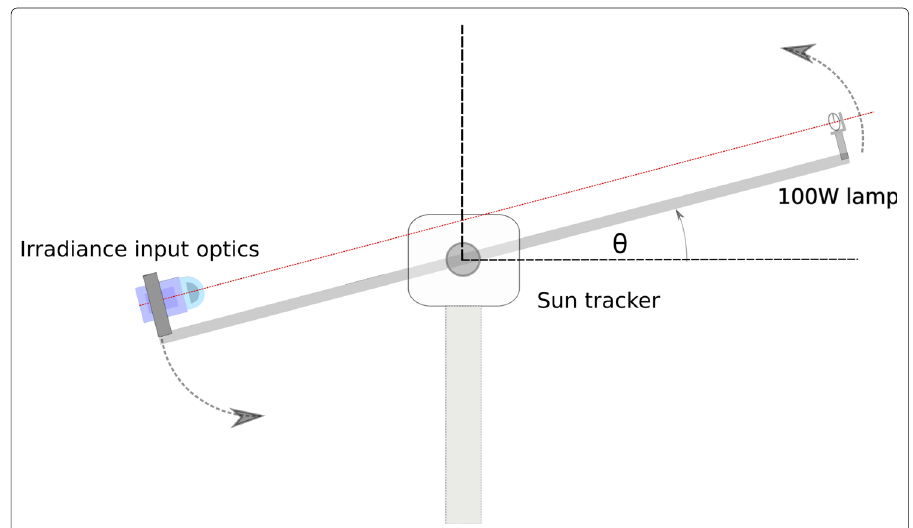
Fig. 10 Optical setup for vertical emission measurements. The lamp-input optics setup rotates around the axis of the tracker. The irradiance of the lamp is measured in steps of 10° to the base). At an angle of 0°, the area of the filament facing the entrance optics was at its maximum (12.69 mm 2 ). For an angle of ± 90°, the area of the filament was only 5.72 mm 2 . A clear wavelength dependence was not found. We can conclude that in order to prevent the effects in the change of irradiance, the lamp needs to point to the entrance optics with the same surface area.